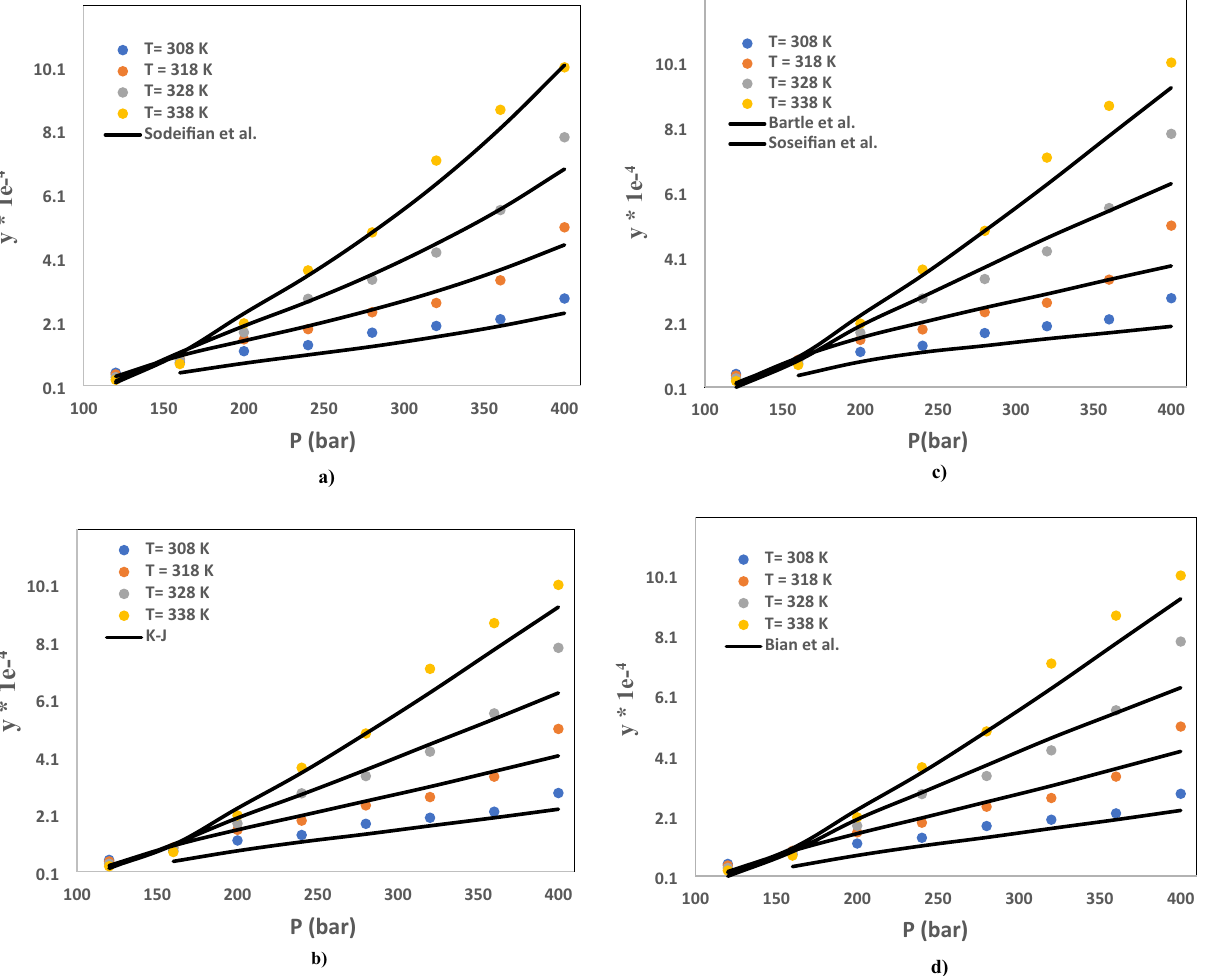
Figure 8. Comparison of correlation outcomes for Decitabine-SC-CO 2 system using various semi-empirical models. ( a ) Sodeifian et al. ( b ) K-J, ( c ) Bartle et al. and ( d ) Bian et al.